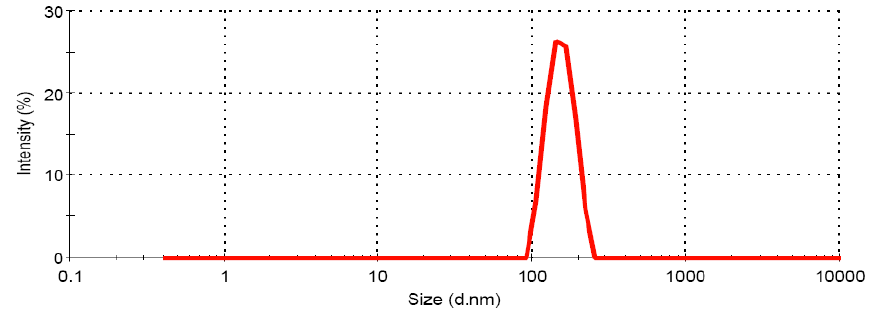
Figure 1. Zeta sizer analysis of a diluted lipidic formulation of Curcumin (CRM-LF).